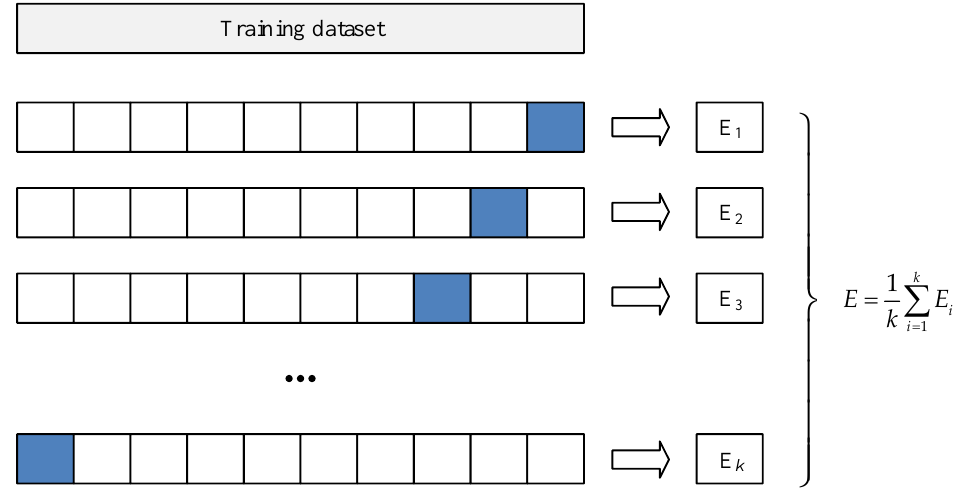
Figure 4. k -fold cross-validation.